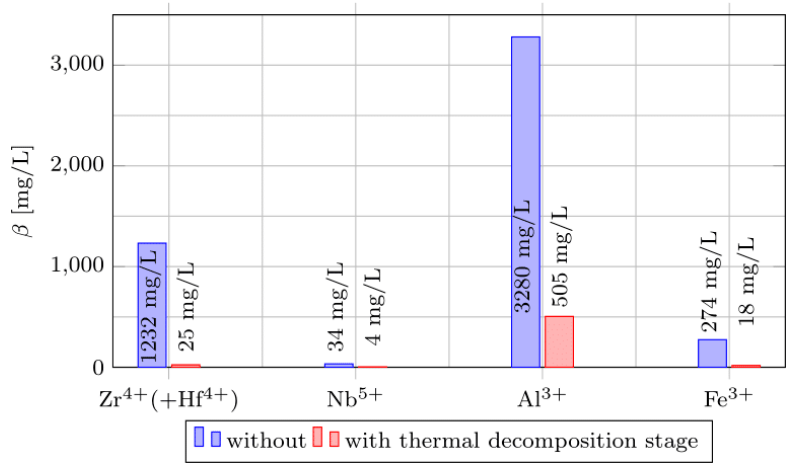
Figure 11. Effect of roasting stage on leaching yields of Zr 4+ (+Hf 4+ ), Nb 5+ , Al 3+ and Fe 3+ at ϱ PD,L = 100 Figure 11. E ff ect of roasting stage on leaching yields of Zr 4 + ( + Hf 4 + ), Nb 5 + , Al 3 + and Fe 3 + at (cid:37) = 100 kg / m 3 kg/m 3 . PD,L